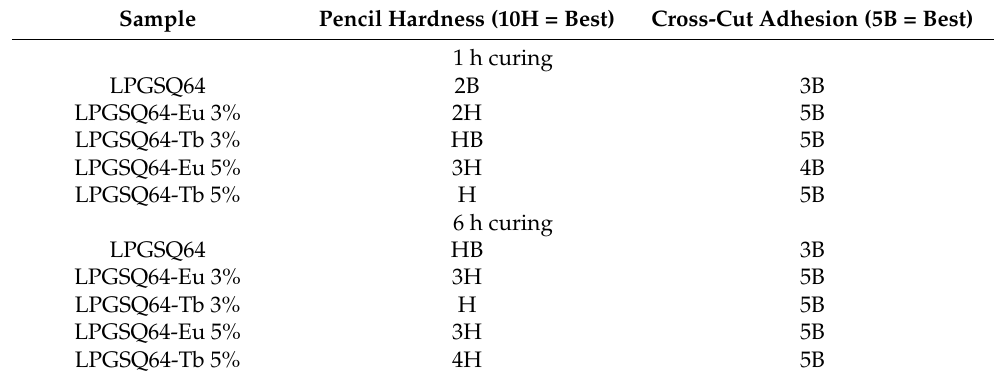
Table 2. Pencil hardness and delamination fraction (adhesion) from a cross-cut tape test of the LPGSQ64, LPGSQ64–Eu, and LPGSQ64–Tb films cured for 1 h and 6 h with 3% and 5% doping. Sample Pencil Hardness (10H = Best) Cross-Cut Adhesion (5B = Best) 1 h curing